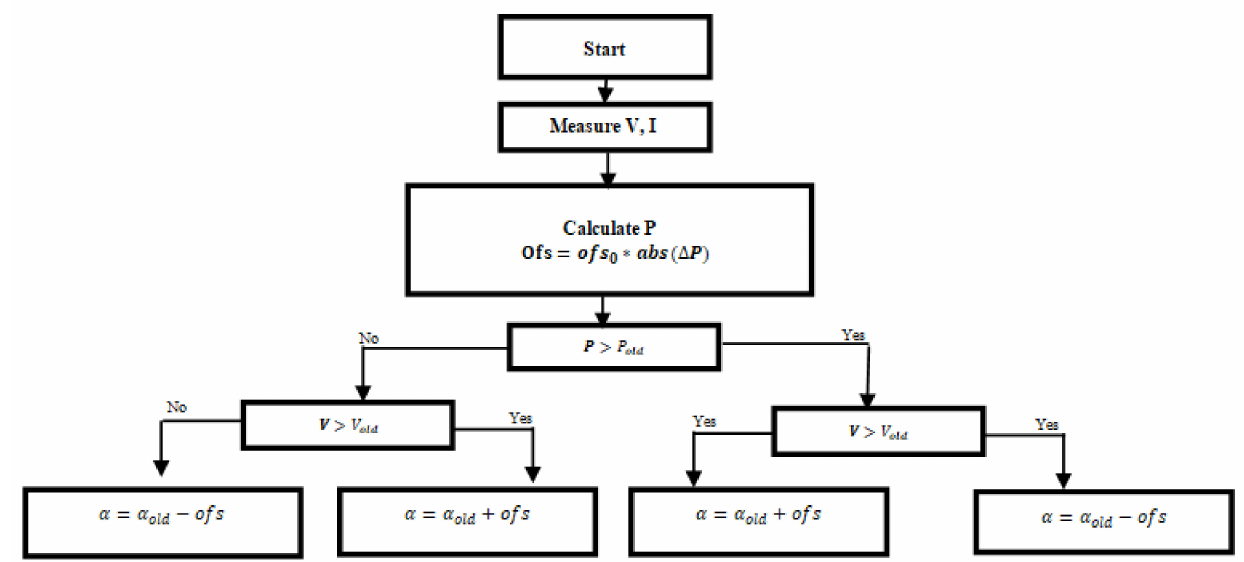
Figure 6. Flowchart of variable step perturb and observe